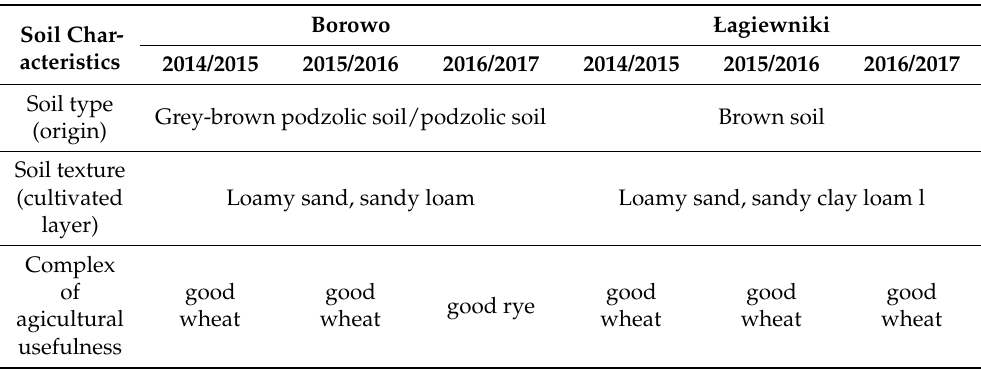
Table 3. Soil characteristics in the five trial locations–in crop seasons 2014/2015, 2015/2016 and 2016/2017.